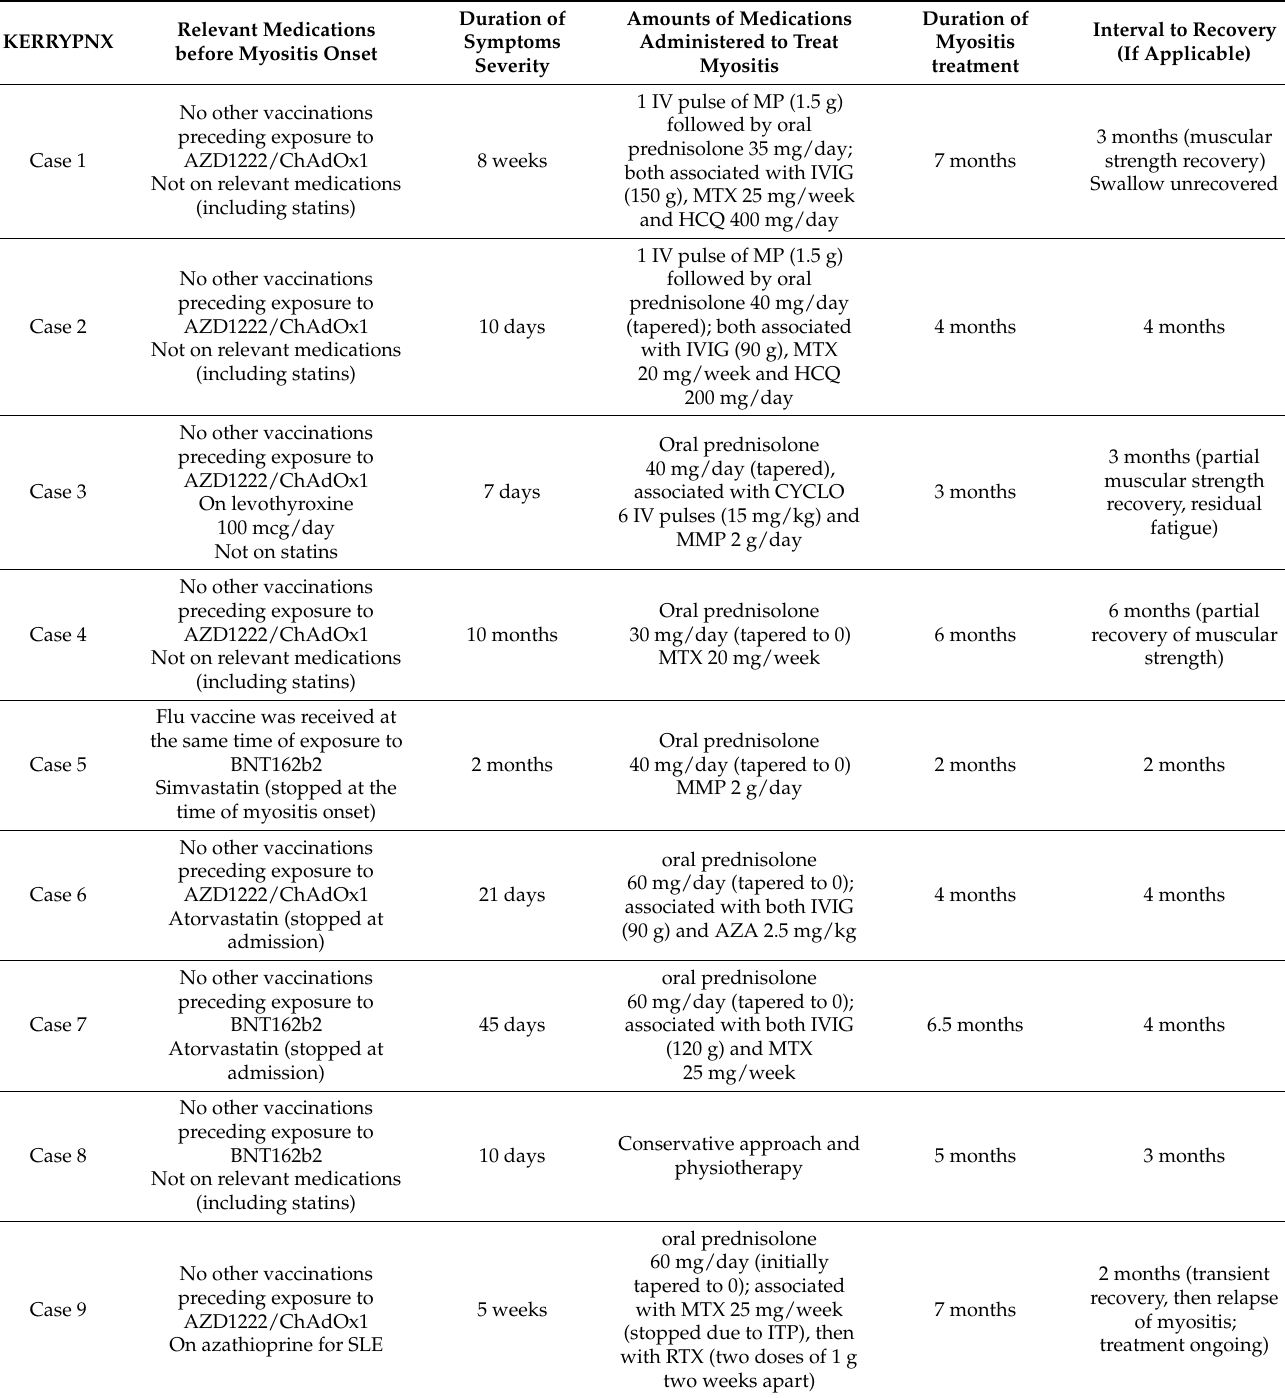
Table 2. Myositis Cases Therapy and